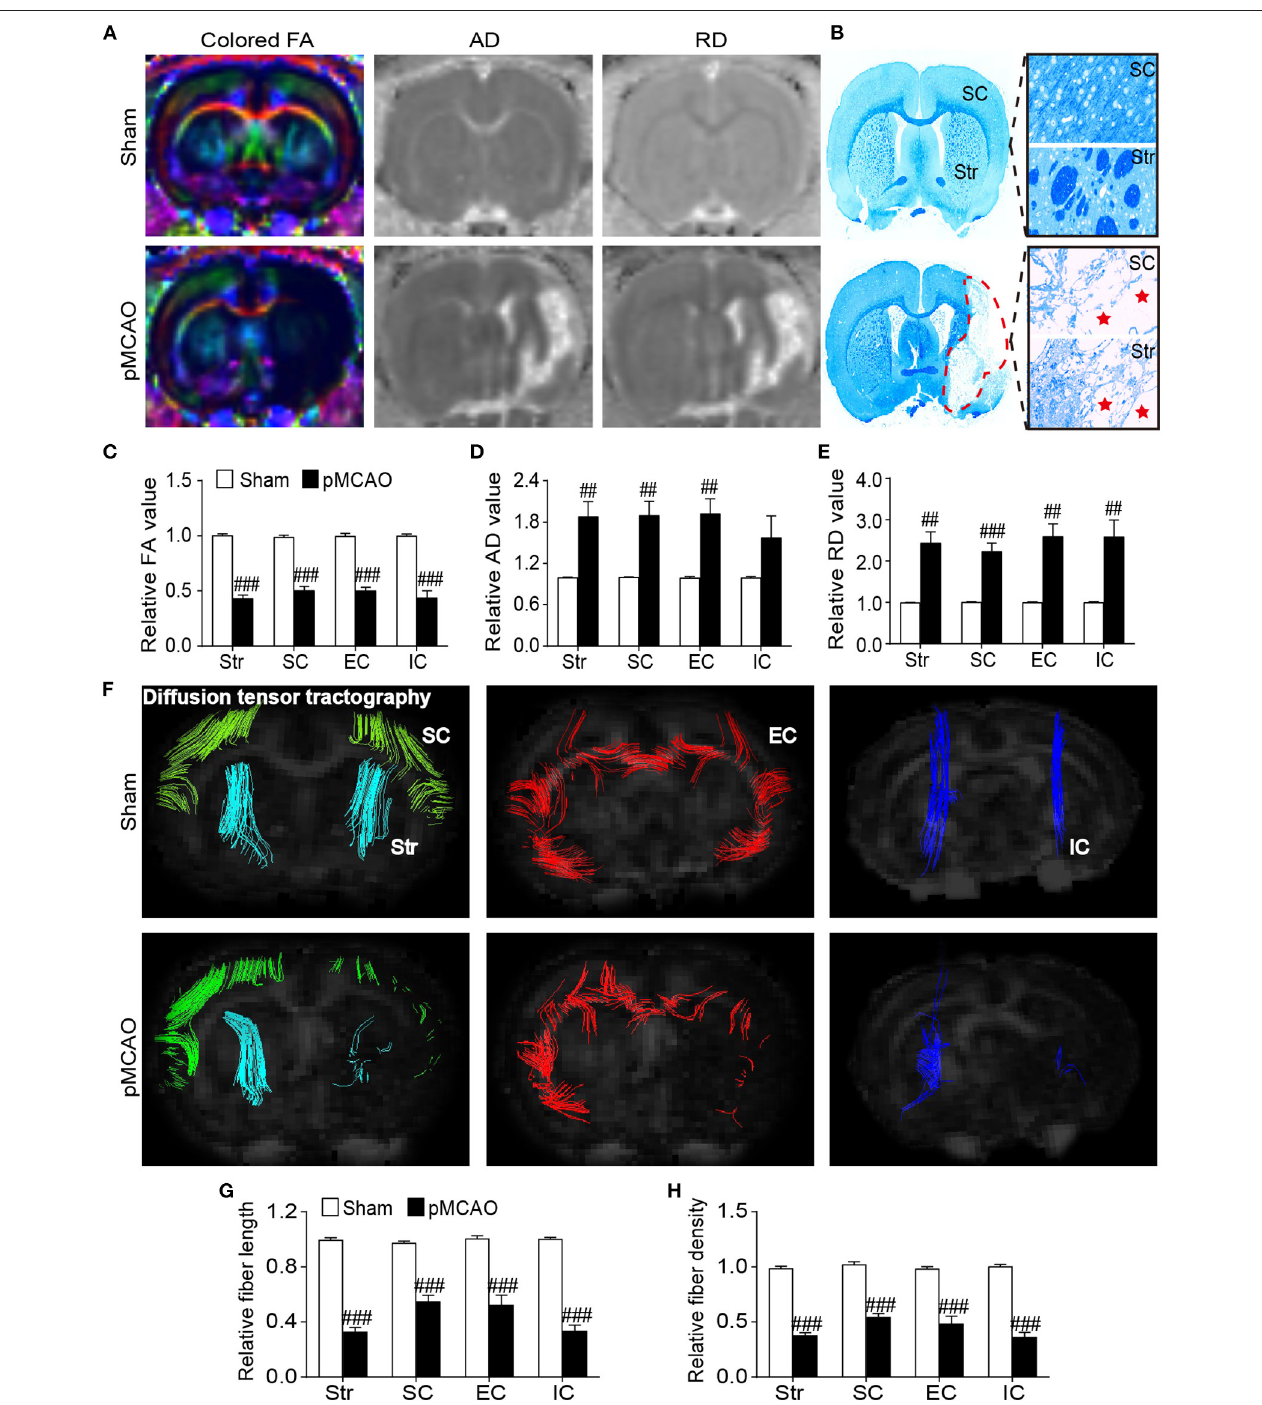
FIGURE 5 | pMCAO induced microstructural damages of the cerebral gray and white matter in rats. (A) Representative colored FA, AD, and RD images of the sham and pMCAO rats. (B) Typical LFB staining images of the sham and pMCAO rats. (C–E) Quantitative analysis of the relative FA, AD, and RD, respectively. (F) Diffusion fiber tracking with the seed placed on the bilateral sensorimotor cortex (SC), striatum (Str), external capsule (EC), and internal capsule (IC). (G,H) Quantitative analysis of the relative fiber length and fiber density, respectively (Student’s t -test, N = 8 for the sham group and N = 9 for the pMCAO group). ## P < 0.01, ### P < 0.001 vs. sham